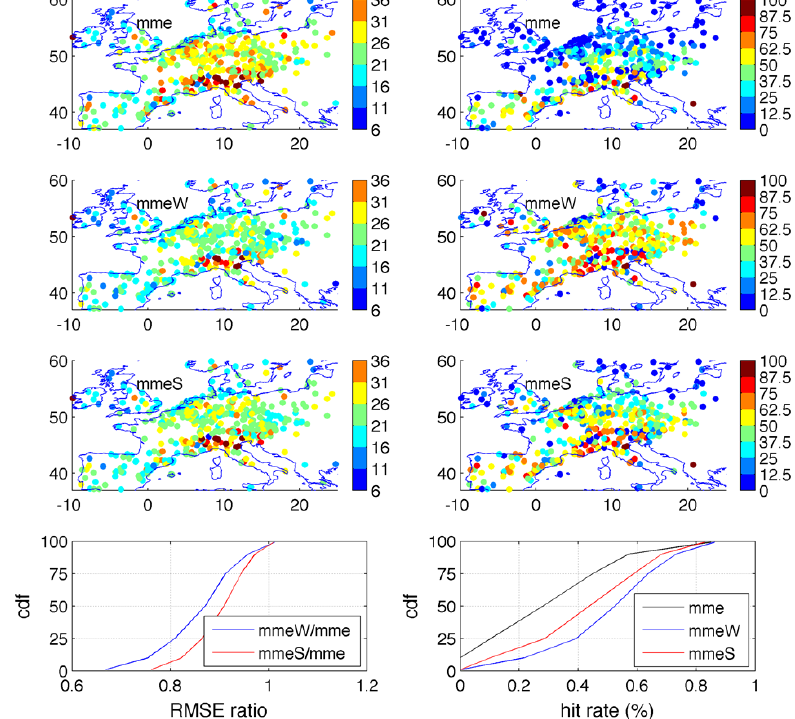
Figure 10. Top row: the RMSE of ozone at each observed site for mme (left). The behaviour at the upper tail of the distribution; percentage of correct hits for events > 120µgm 3 for mme (right). Second/third rows: as top row but for mmeW and mmeS. Bottom row: the cdf of each spatial